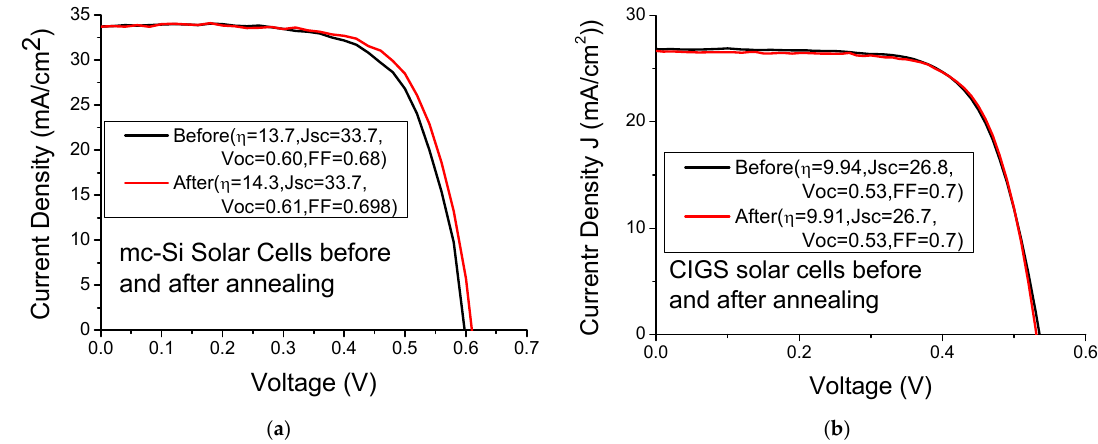
Figure 3. Current ‐ voltage curves of ( a ) mc ‐ Si and ( b ) copper ‐ indium ‐ gallium ‐ diselenide (CIGS) solar cells before and after thermal annealing under AM1.5 illumination.